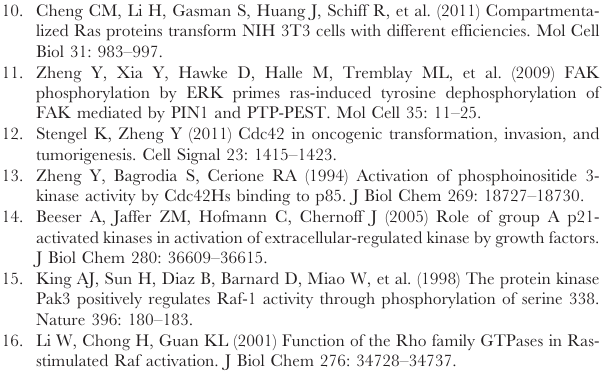
floating cells were harvested for immunoblotting for cleaved caspase 3. Gapdh serves as a loading control. (EPS) Figure S2 Cdc42 overexpression in HRasV12 cells does not increase proliferation, but enhances anchorage- independent cell growth. (a) HRasV12-transformed cells were retrovirally transduced with wild-type Cdc42 or vector control. Cell lysates were blotted for Cdc42. (b) An Equal number of Cdc42 overexpressing and vector control cells were plated on day 0. Cells were counted every 3 days by trypan blue exclusion. Experiment was performed in triplicate. (c) Vector control and Cdc42-overexpressing cells were grown in 0.3% agarose. Colonies were counted one week and three weeks after plating. Experiments were performed in triplicate with 9 independent fields counted. Figure S3 Cdc42 deficiency is selected against in HRasV12 cells, but not c-Myc transformed or non- transformed cell lines. Following Cdc42 deletion, an equal number of Cdc42 + and Cdc42 2 cells were seeded. At confluency, cells were passaged and a small number harvested for PCR to assess the relative abundance of the loxp and recombined cdc42 alleles. Cultures were passaged a total of three times. Band intensity was determined using imageJ software, and the percentage of non-recombined to recombined cdc42 was plotted relative to the initial seeding. Figure S4 Cdc42 deficiency alters activation of Akt, but not MEK-ERK signaling. Non-transformed and HRasV12 transformed cells were harvested for western blot analysis following deletion of Cdc42. Membranes were blotted with the indicated antibodies.